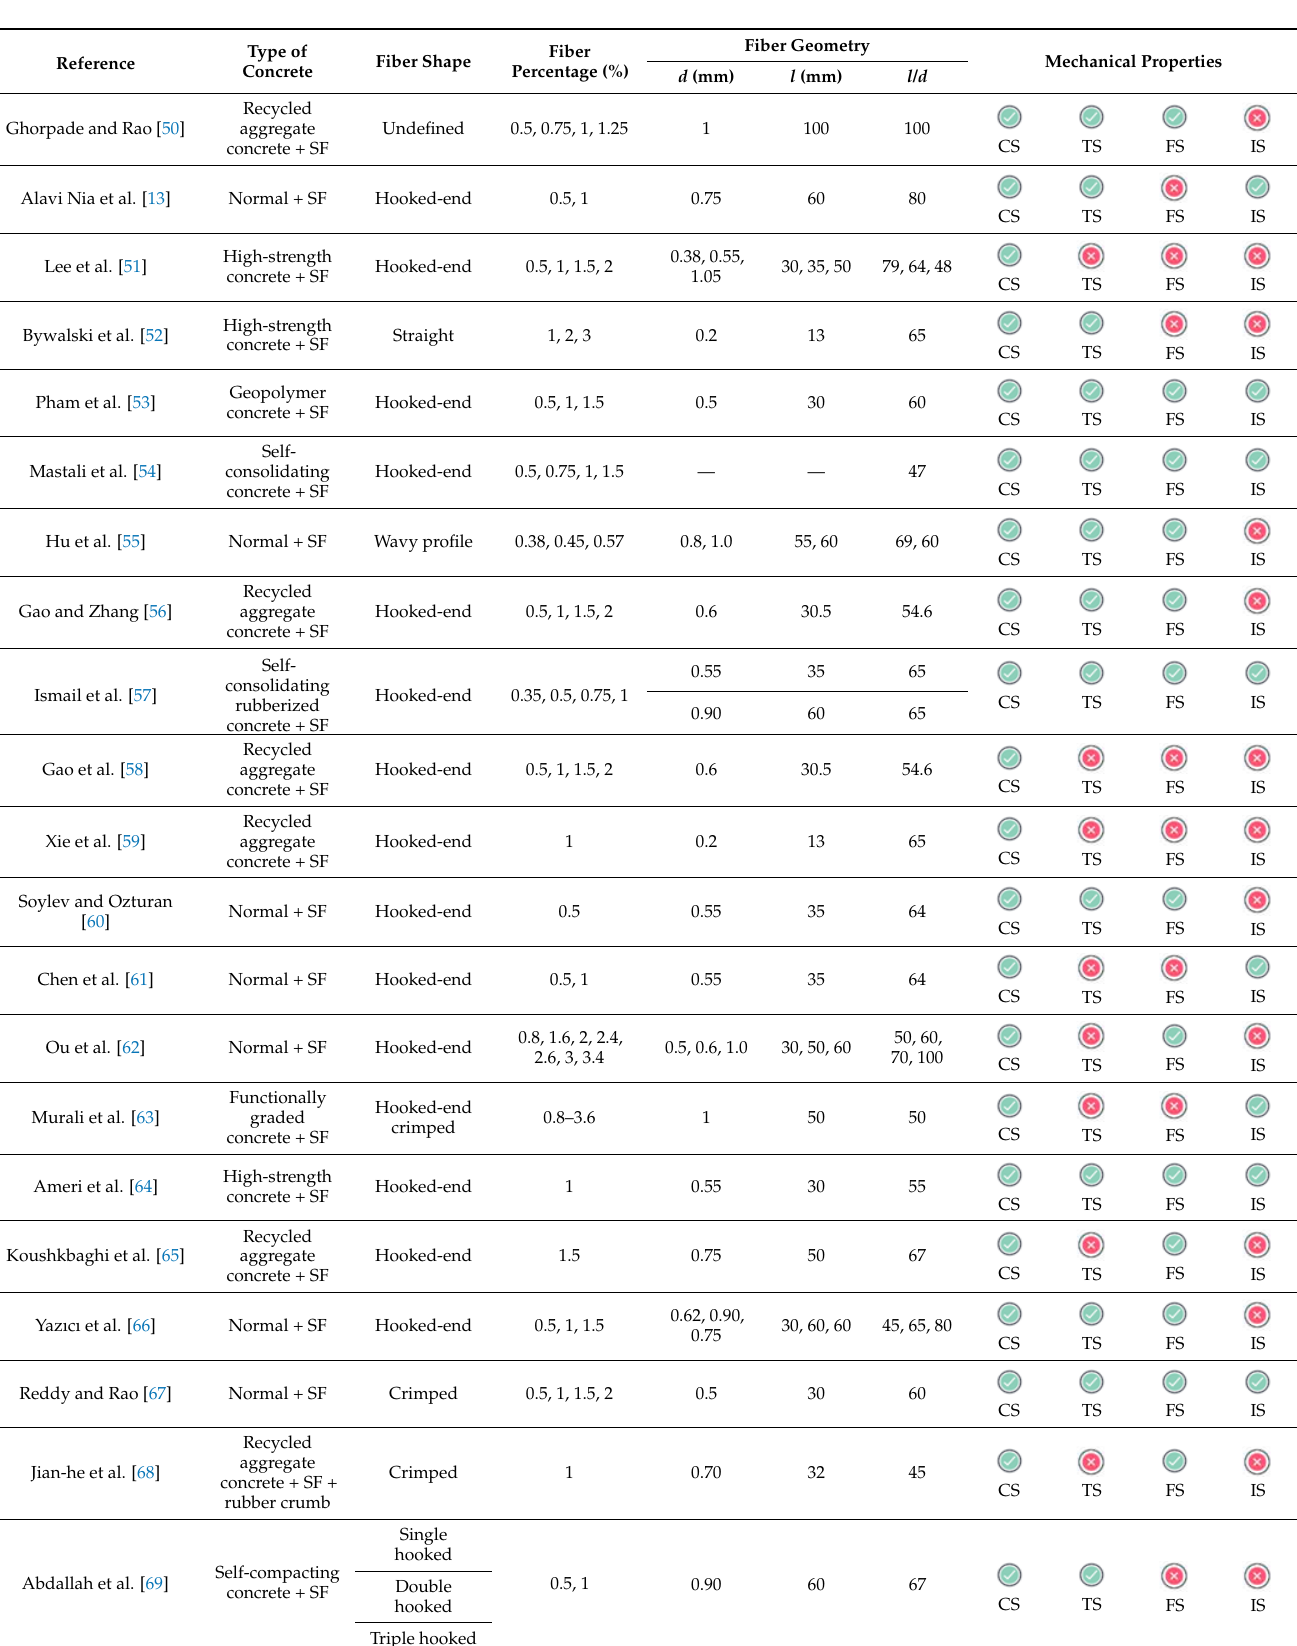
Table 1. Information on previous studies.